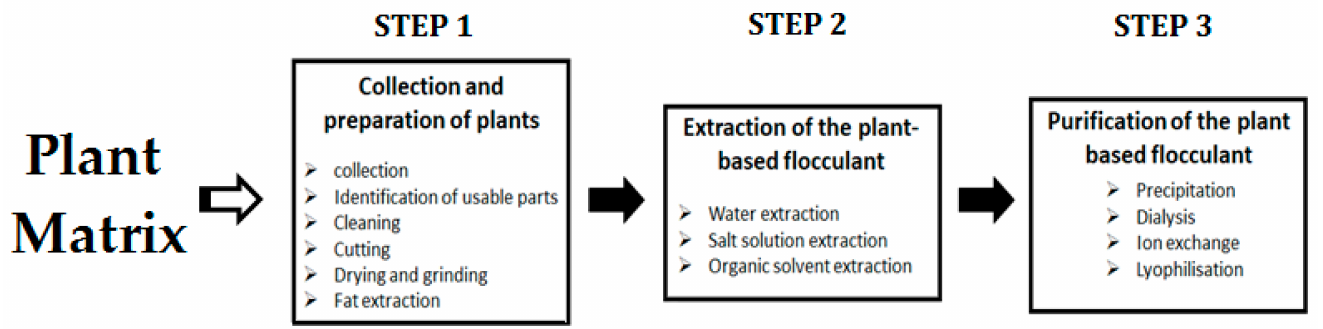
Figure 2. General process of the preparation of the plant-based flocculants.